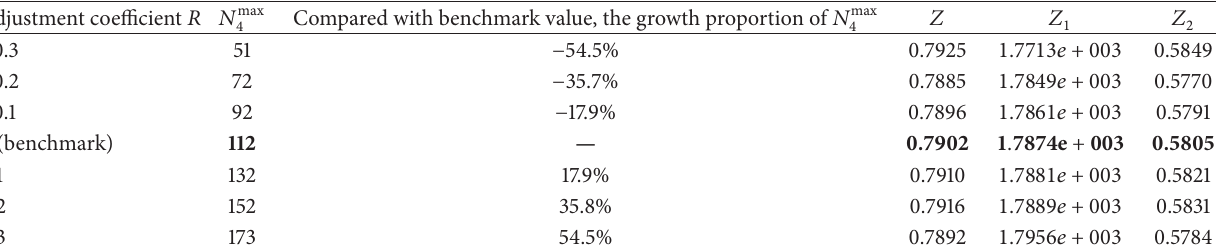
Table 7: Effect of 𝑁 on 𝑁 max 𝑗